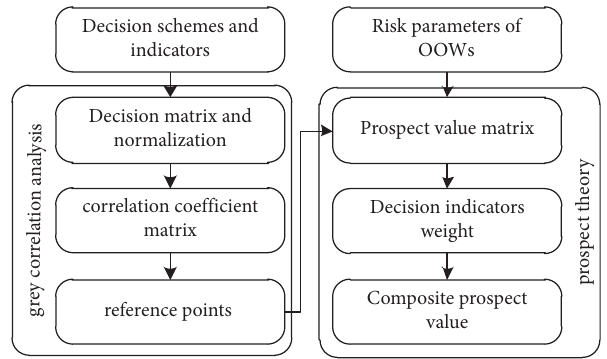
Figure 4: The framework for CMDA